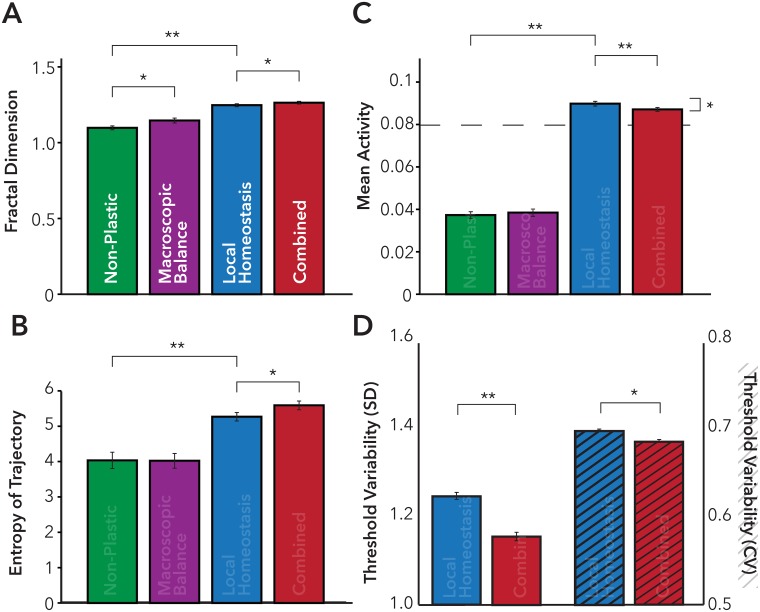
Behavioral and functional dynamics of the computational model.Plots of Fractal Dimension (A), and Entropy of the movement dynamics (B) for each version of the computational model. C) Mean activity over 2000 epochs of the computational model—Dashed line represents the overall target rate of the homeostatic tuning function selected for the Homeostatic and Combined local and macroscopic models. D) Exploration of the threshold variability for the Local Homeostatic (Blue) and Combined local and macroscopic (Red) Models. (n = 30 repeats of the model ± 1 SEM, ** = p<0.001, * = p<0.05).